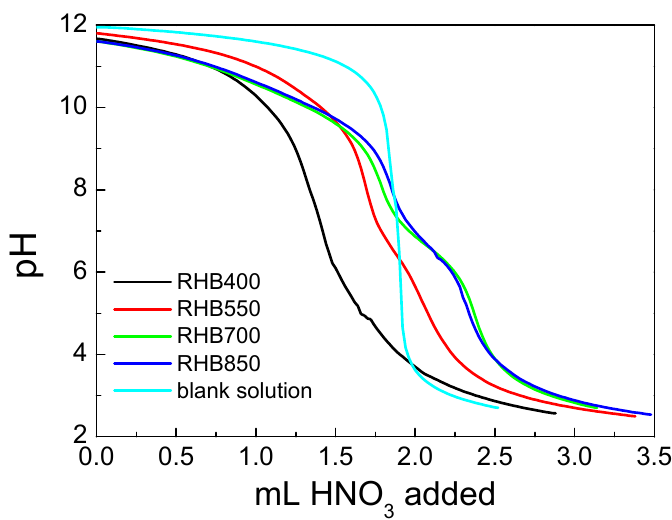
Figure 6. Potentriometric titration curves for the rice husk (RH) biochars and the blank